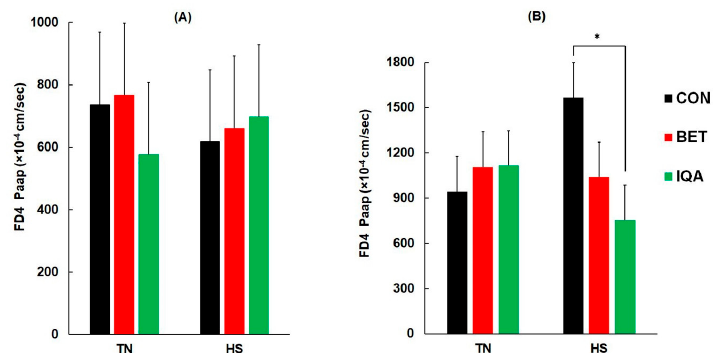
Figure 3. Effect of heat stress (HS) and thermoneutral (TN) conditions on ileal ( A ) and colonic ( B ) fluorescein isothiocyanate dextran (4 k Da) apparent permeation coefficient (FD4 P app ) of growing pigs fed control diet (CON), the control plus betaine (BET) or the control plus isoquinoline alkaloids (IQA). Results are adjusted mean ± SED and n = 8–9 pigs per group. ( A ) The p -value for the effects of temp., diet and diet*temp were 0.77, 0.90 and 0.71 respectively. ( B ) The p -value for the effects of temp., diet and diet*temp were 0.56, 0.23 and 0.030 respectively. * denotes p < 0.05 as determined by Fisher’s least significant difference test.